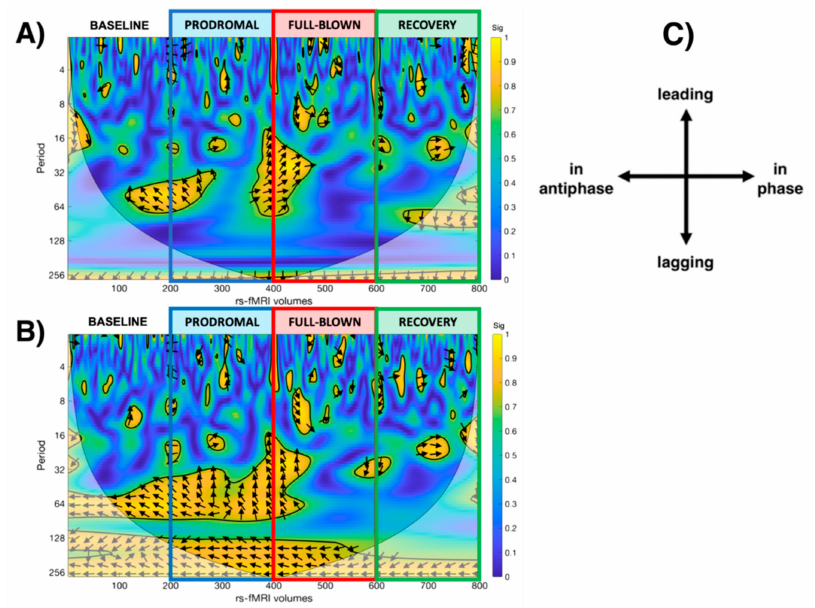
Figure 4. Scalogram representing the statistically significant WCA analysis results showing the dynamic correlation with the salience network during each phase of the study (baseline, prodromal, full-blown, recovery), considering the ( A ) left thalamus and the ( B ) right thalamus as a seed. ( C ) legend for the interpretation of the direction of the arrows (phase